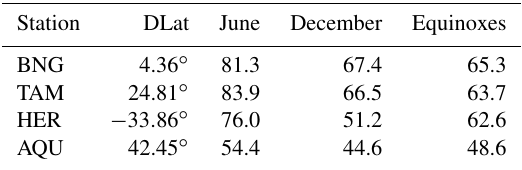
Table 3. Mean dawn − dusk differences of the H component val- ues (in nT) from Table 2 at four observatories for different seasons during active times (Kp > = 6).